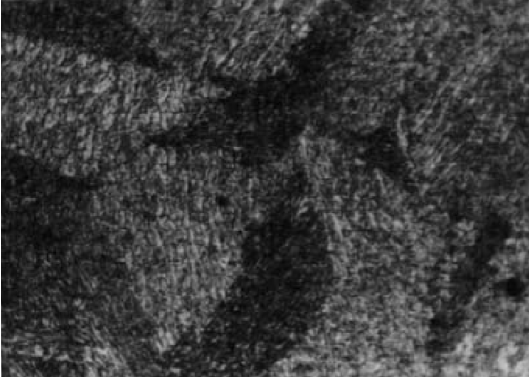
Fig. 10. Microstructure of aging samples at 650 o C for 16 hours